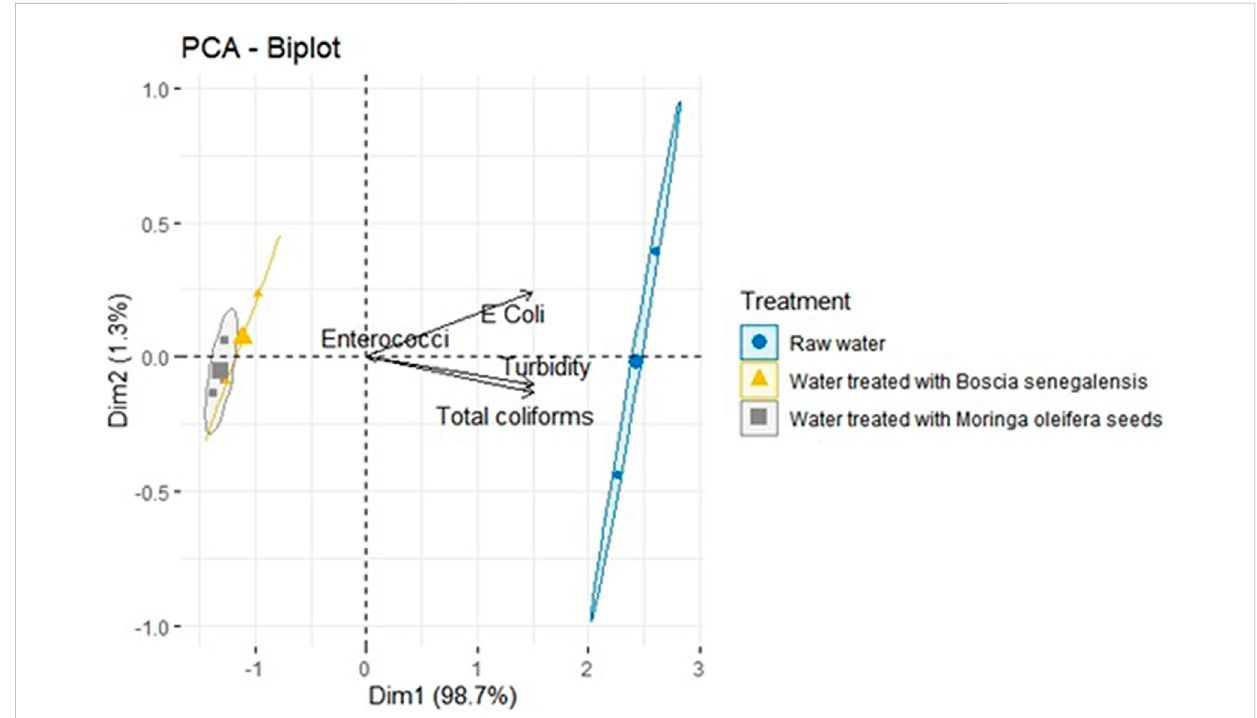
FIGURE 12 Principal component analysis of microbiological parameters of water treated with Moringa oleifera seeds and Boscia senegalensis seeds.